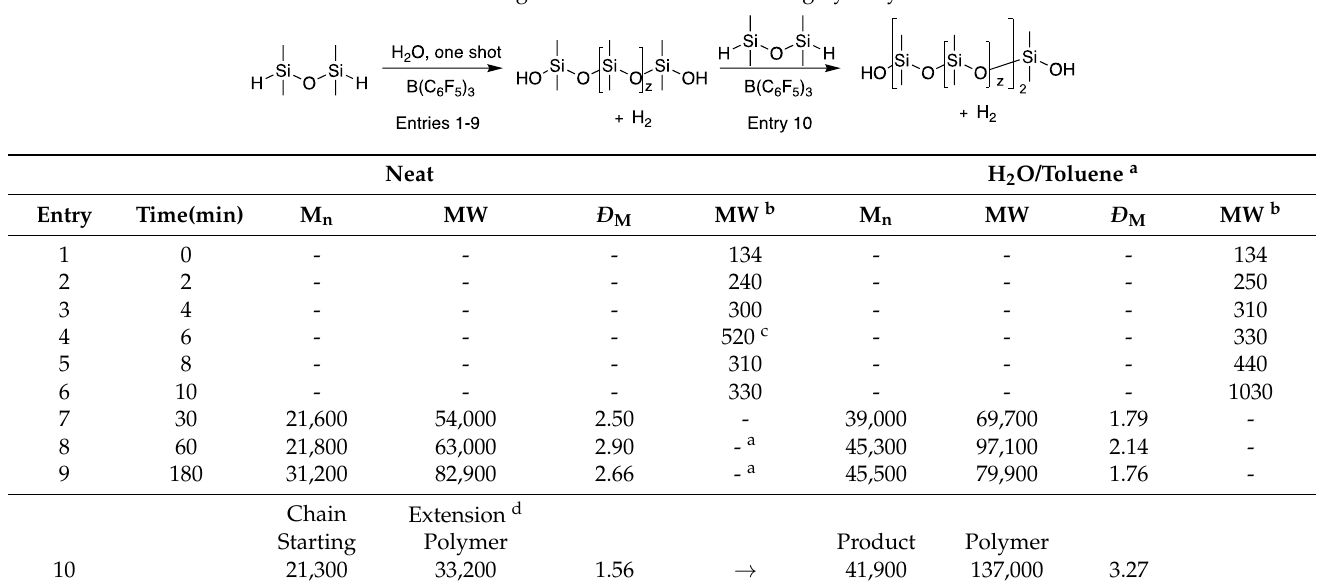
Table 2. Molecular weight versus reaction time using hydrolysis of M H M H .